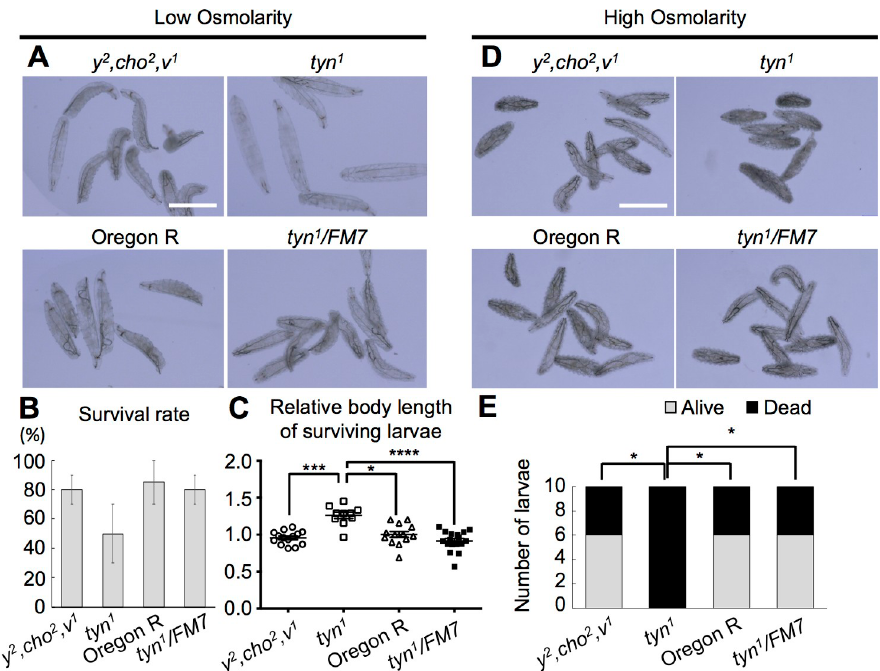
Fig 2. Defective barrier function against osmolarity in tyn mutants. First-instar tyn 1 , y 2 , cho 2 , v 1 larvae showed obvious swelling in water (A-C) and shrinkage in hyper-osmotic solution (D, E) compared with control groups, y 2 , cho 2 , v 1 , Oregon R, and tyn 1 , y 2 , cho 2 , v 1 /FM7 . (A) Larvae kept in water overnight. (B) The survival rate was calculated by dividing the number of moving larvae by that of total larvae (10 larvae for each of 2 trials, average values ± S.E.M are shown.). There was no significant difference (P = 0.29 by Kruskal Wallis test). (C) Median body length normalized to that of Oregon R. ���� P < 0.0001, ��� P < 0.001, � P < 0.05 by Dunn’s multiple comparisons test after a Kruskal-Wallis test (P < 0.0001). (D) Larvae kept in high-salt solution for 30 min. (E) All 10 of the tyn 1 , y 2 , cho 2 , v 1 larvae died, while 6 of the 10 larvae survived in each of the three control groups. � P < 0.05 by Fisher’s exact test with Benjamini & Hochberg correction. Scale bar: 500 μ